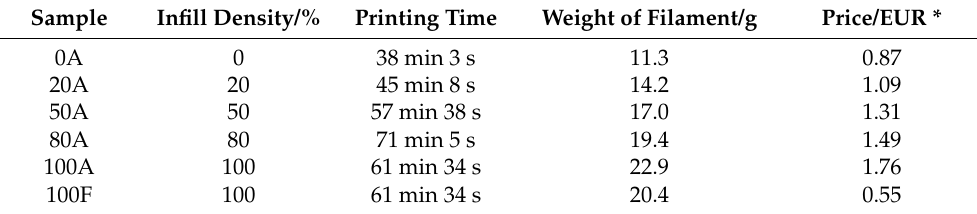
Table 1. Summarization of printing processes for all produced